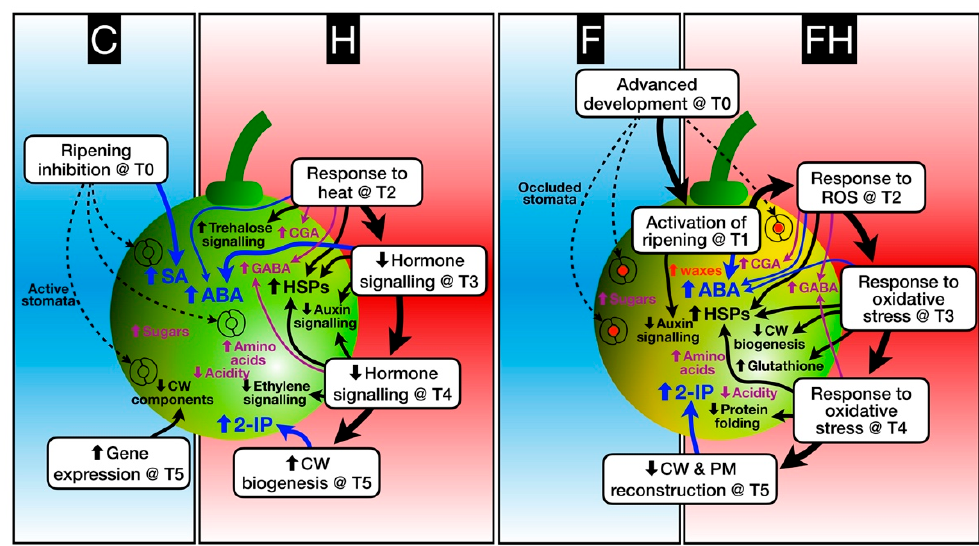
Figure 11. Model summarizing the specific responses of the berry to each treatment (C, control; F, flooded; H, heatwave; FH, flooded plus heatwave). The position of each item with respect to the background boxes, both outside and inside the stylized berries, refers to the specificity of the response. When an item overlaps both boxes, it means that the particular response was shown in both treatments. The main transcriptional responses inferred from RNAseq data and GO terms enrichment analyses are shown with black text on the white background outside the berry. Black arrows link these general responses to more detailed transcriptional information (inside the berry), while the blue arrows connect with hormonal responses inferred from hormone profiling. Finally, the metabolic responses are shown in violet and can be either linked to a particular timepoint response outside the berry or not. In the latter case, the metabolic response was generally observed during the whole experiment. Stomata are also shown, either active or occluded, by waxes (red circle), as discussed in the main text. (2 ‐ IP, 2 ‐ isopentenyladenine; ABA, abscisic acid; CGA, chlorogenic acid; CW, cell wall; GABA, γ‐ aminobutyric acid; HSPs, Heat Shock Proteins; PM, plasma membrane; ROS, reactive oxygen species; SA, salicylic acid).